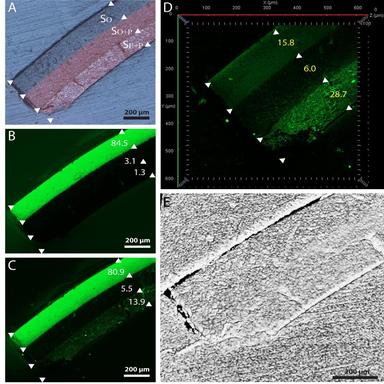
Cross section images of the yellowish red coloured micro (model) sample, containing the pigment vermilion, photographed prior to antibody hybridisation using the reflected-light brightfield observation (texp 2.3 ms, frame A) and the widefield fluorescence observation (texp 400 ms, frame B) modes. After antibody hybridisation, the sample was again captured in the widefield fluorescence observation mode under the same illumination conditions (frame C) and was laser scanned using confocal fluorescence microsco